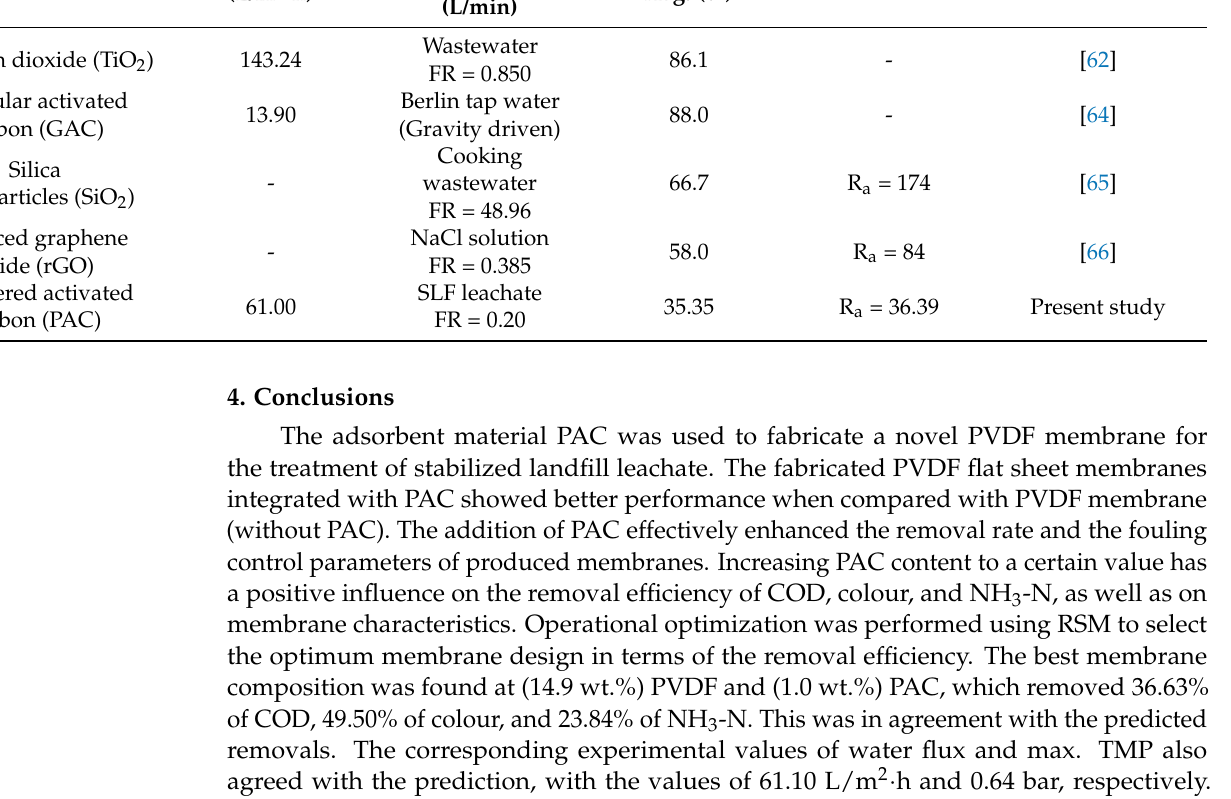
Table 8. Comparison of performance with other modified PVDF membranes in wastewater treatment process. Pure Water Modification Agent